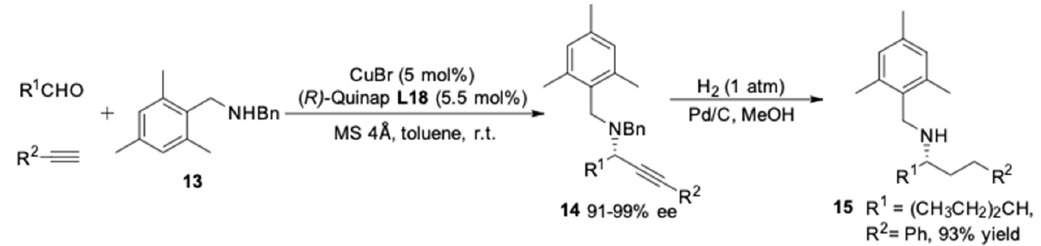
Figure 18. Asymmetric A 3 -couplings of bulky secondary amine.